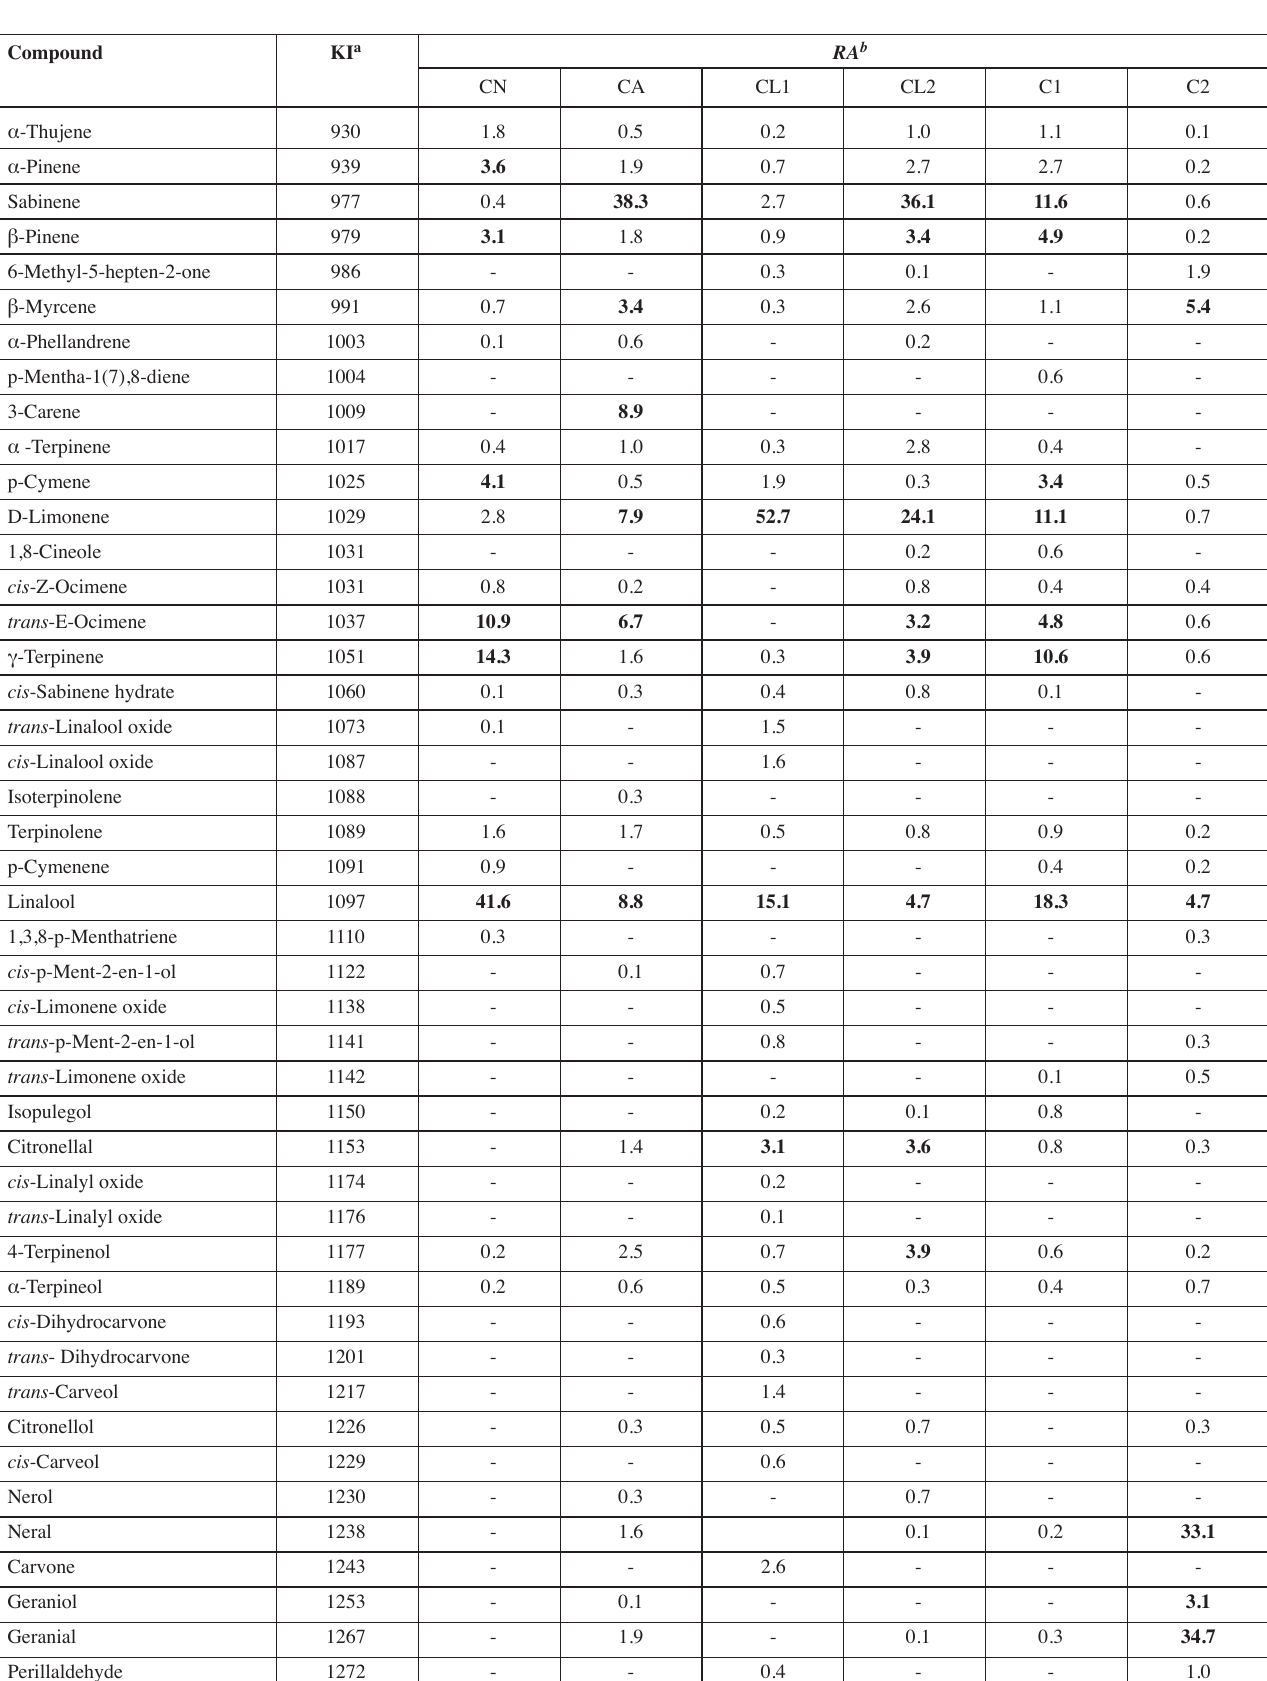
Tab. 1: Chemical composition of Citrus